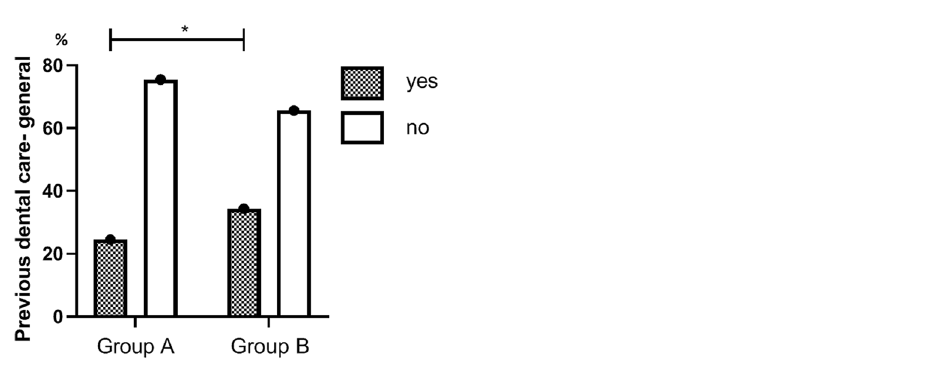
Figure 1. Previous dental care of patients hospitalized before and after (group A and B, respectively) inclusion of pediatric dental care in Israel’s National Health Insurance Law. The bars show the percentages of patients who received dental care prior to hospitalization. The difference between the groups in the percentage of those who received treatment is statistically significant. *p-value <